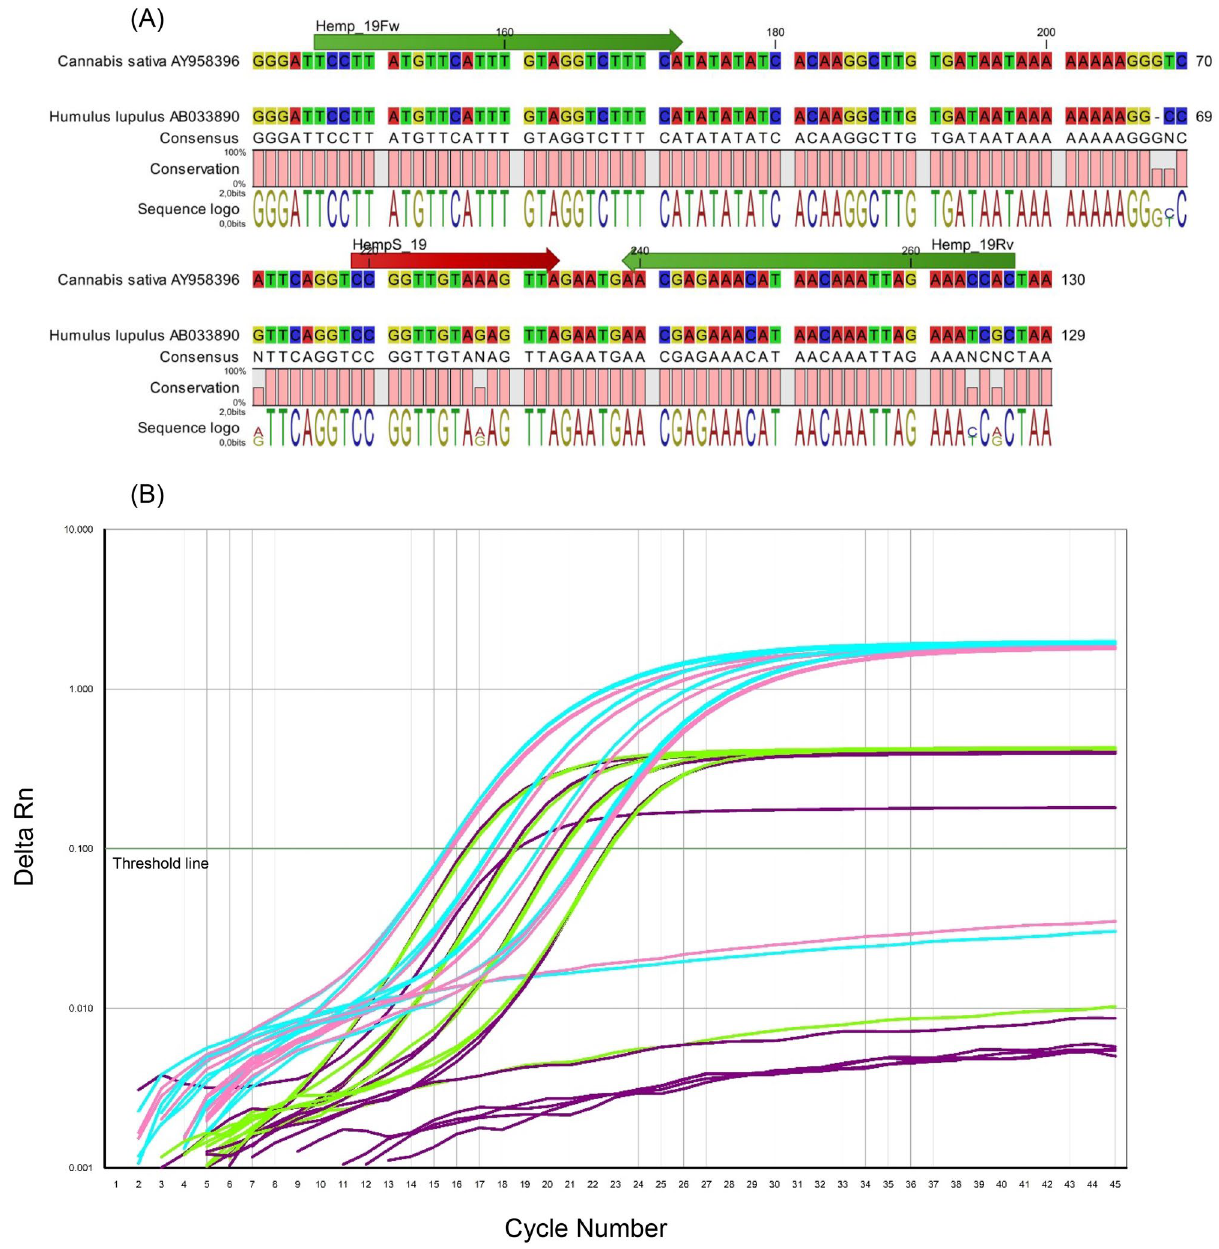
Figure 5. ( A ) Position of primers and probe presented in the spacer DNA sequence between the trnL 3´exon and the trnF gene in Cannabis sativa chloroplasts. The probe HempS_19, marked in red, discriminates hemp from hops based on a SNP in position 603. The primer pair Hemp_19 Fw/Rv is marked in green. ( B ) Amplification curves obtained with tested primer and probe concentrations by analysing Monoica seeds with DNA concentrations of 100 ng/µl, 25 ng/µl, 6.25 ng/µl and 1.5625 ng/µl. (1) Purple: 0.5 µmol/L per primer, 0.1 µmol/L probe. (2) Light blue: 0.5 µmol/L per primer, 0.25 µmol/L probe. (3) Rose: 0.25 µmol/L per primer, 0.25 µmol/L probe. (4) Green: 0.25 µmol/L per primer, 0.1 µmol/L